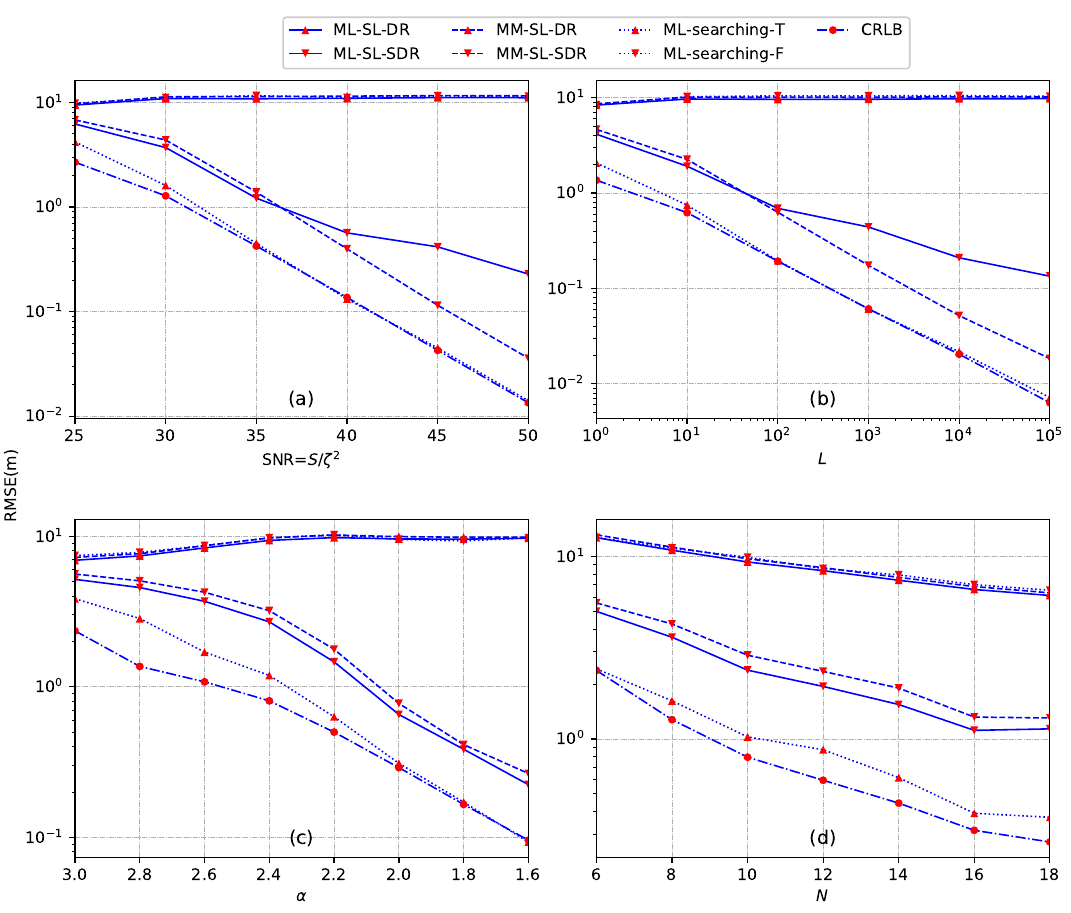
Figure 7. Performance analysis when the source is located randomly in a region of size 50 × 50 m 2 . ( a ) RMSE versus SNR; ( b ) RMSE versus L ; ( c ) RMSE versus α ; ( d ) RMSE versus N